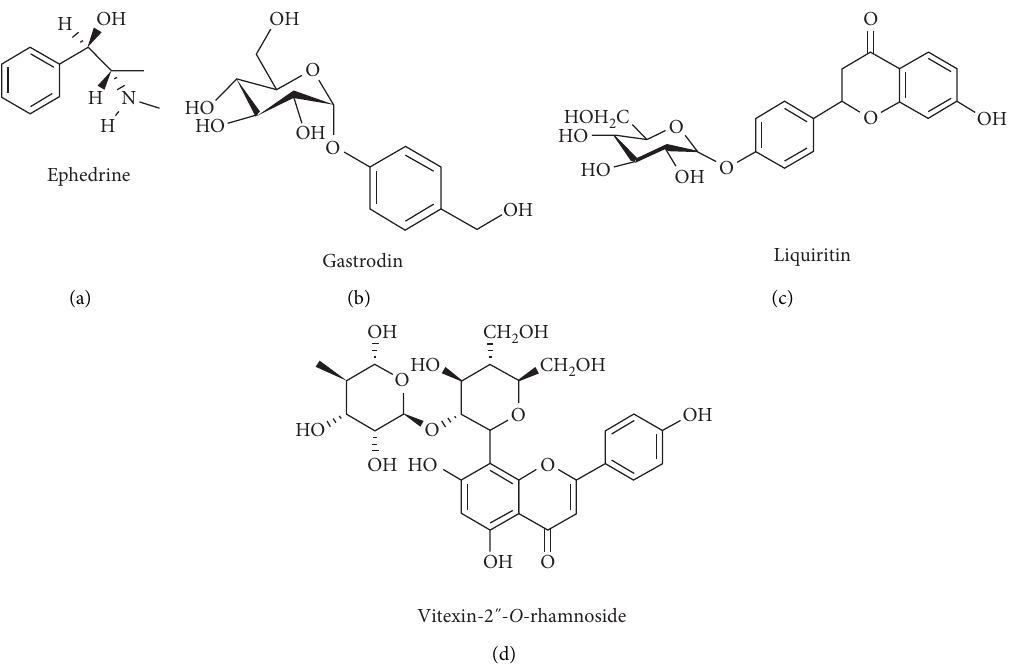
Figure 1: Te chemical structures of ephedrine (a), gastrodin (b), liquiritin (c), and I.S.